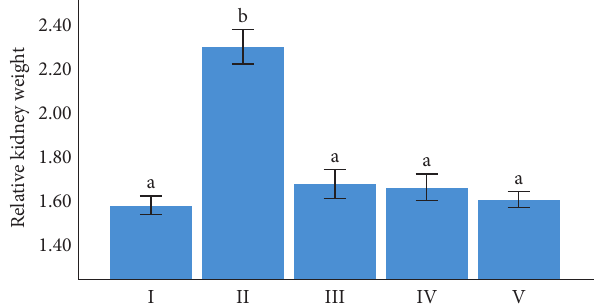
Figure 2: Relative kidney weight of the mice (in percentage). The values were expressed as mean ± SE. The sample size is 6 for each group. I: normal control group; II: negative control group; III: received 100mg/kg/day of green coffee beans; IV: received 200mg/ kg/day of green coffee beans; and V: received 300mg/kg/day of green coffee beans, respectively. Values with different letters are statistically significantly different at p < 0 . 05 as tested by Tukey post hoc multiple